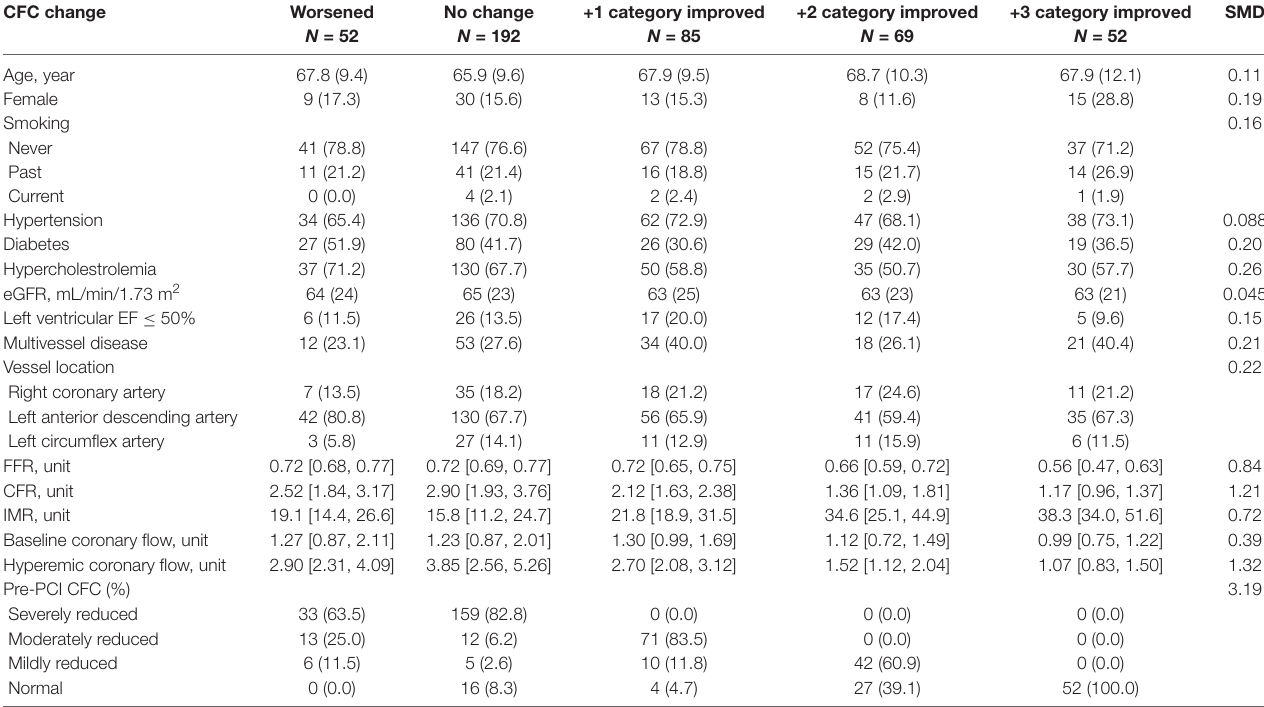
TABLE 2 | Characteristics by categories of CFC changes following